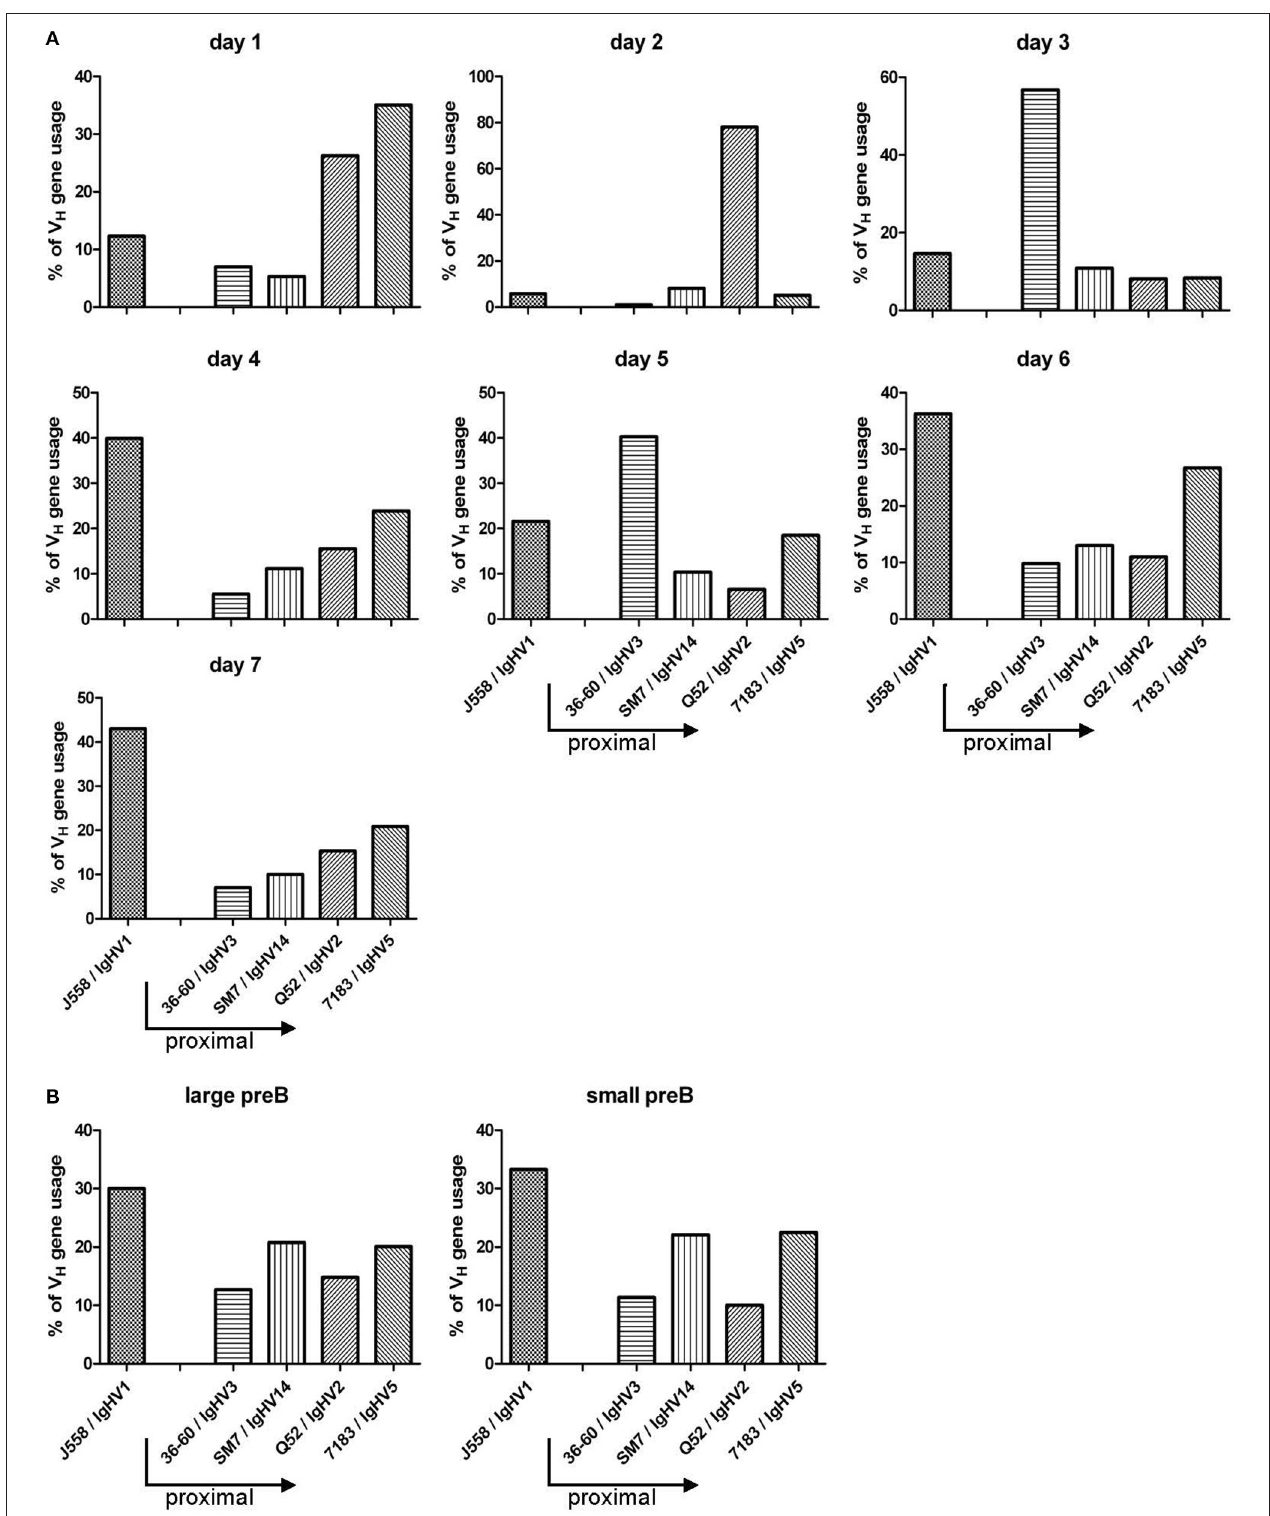
FIGURE 7 | TAM-induced early B cell development in the adult BM is strongly biased toward VDJ rearrangements that involve proximal V H gene segments. (A) Kinetics of V H gene usage in the BM of B-Indu-Rag1 mice after induction of B lymphopoiesis, as revealed by analysis of sequenced RT-PCR products at indicated time points after TAM administration. Mean number of analyzed sequences: 407. (B) Quantification of V H gene usage in FACS-purified populations of large and small preB-II cells from BM of Wt mice (BALB/c) with continuous B cell development. Mean number of analyzed sequences: 472. Arrows in graphs indicate the position of individual V H gene families relative to the D/J clusters of the murine IgH gene locus (proximal to D/J: 36-60, SM7, Q52, 7183; distal: J558).